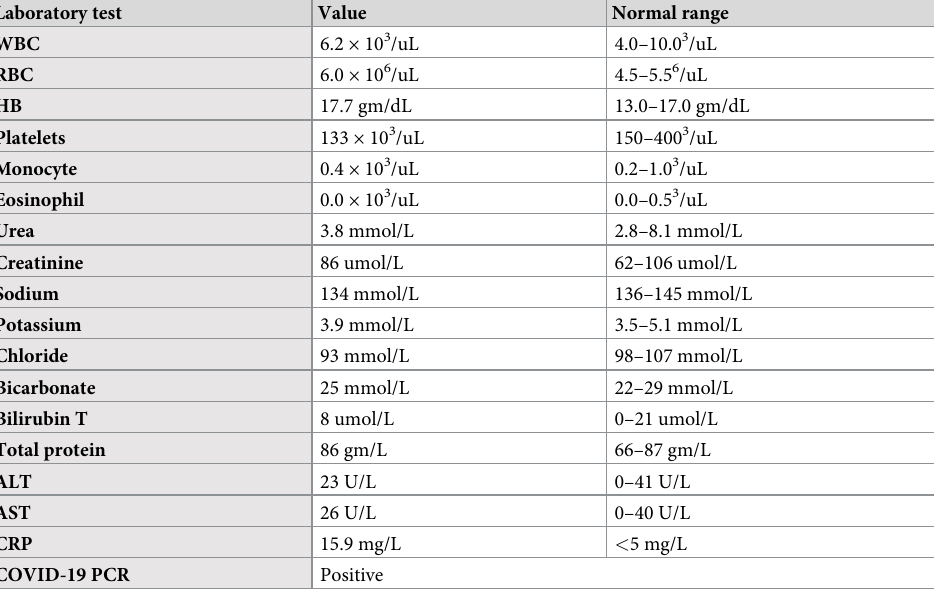
Table 1. The patient’s laboratory